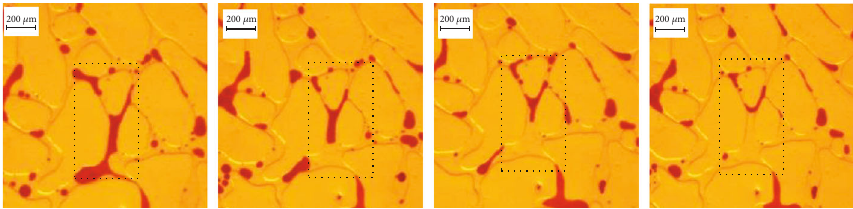
Figure 12: Schematic diagram of the displacement process of cluster residual oil (oil in pores is indicated by the red